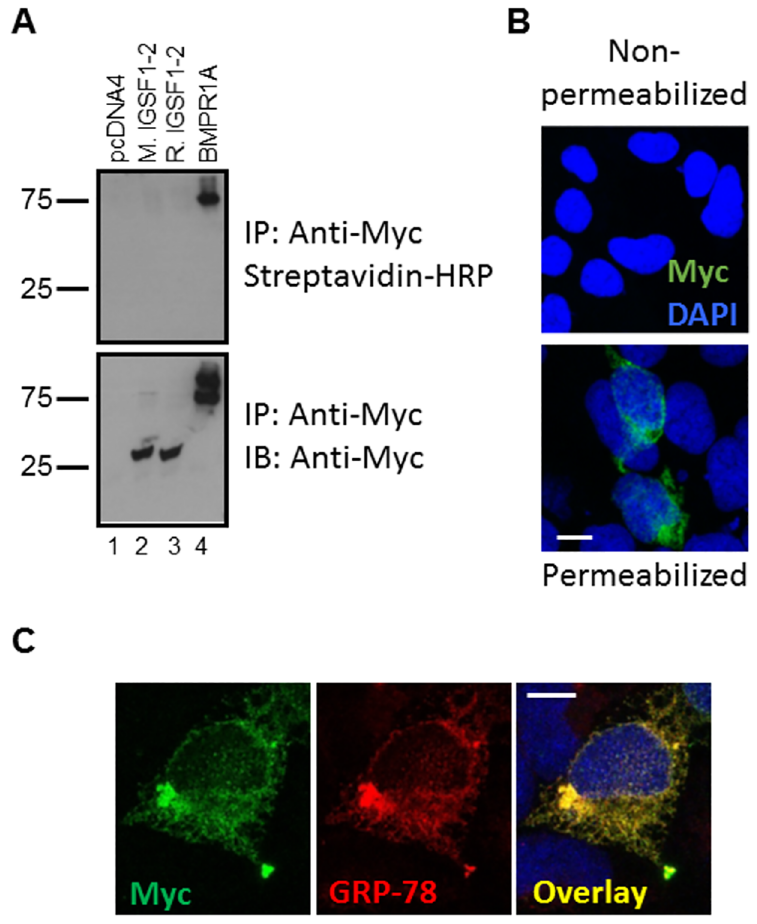
Fig 3. Murine and rat IGSF1-2 proteins do not traffic to the plasma membraneof transfected cells. A) HEK293cells were transfected with expressionplasmidsfor wild-typemurine (M.) or rat (R.) IGSF1-2, murine BMP type IA receptor (BMPR1A), or empty vector (pcDNA4). Note, IGSF1-2 proteins were expressedwith Myc/His tags at their C-termini, whereasBMPR1A had the Myc tag alone. Cell surface proteins were labeled with biotin prior to collectionof whole cell lysates. Lysates were immunoprecipitated(IP) with Myc-beads and then subjectedto SDS-PAGE and transferred to nitrocellulose membranes. Total proteins were immunoblotted with anti-Myc (bottom), whereasbiotinylated proteins were identifiedwith streptavidin-HRP (top). B) HEK293 cells were cultured on coverslipsand transiently transfected with wild-typemurine IGSF1- 2-Myc/His. Cells were then fixed and subjectedto immunofluorescencewith a Myc antibody(green) under non-permeabilizing(top) and permeabilizingconditions (bottom). C) Cells were transfected as in panel B, premeabilized, and processedfor double-label immunofluorescencewith the Myc antibody (green)and an antibody against GRP-78/BiP (red). The overlay is shown in yellow. In B and C, nucleiwere stainedwith DAPI. Images were captured by confocalmicroscopy.Scale bar, 10 μ